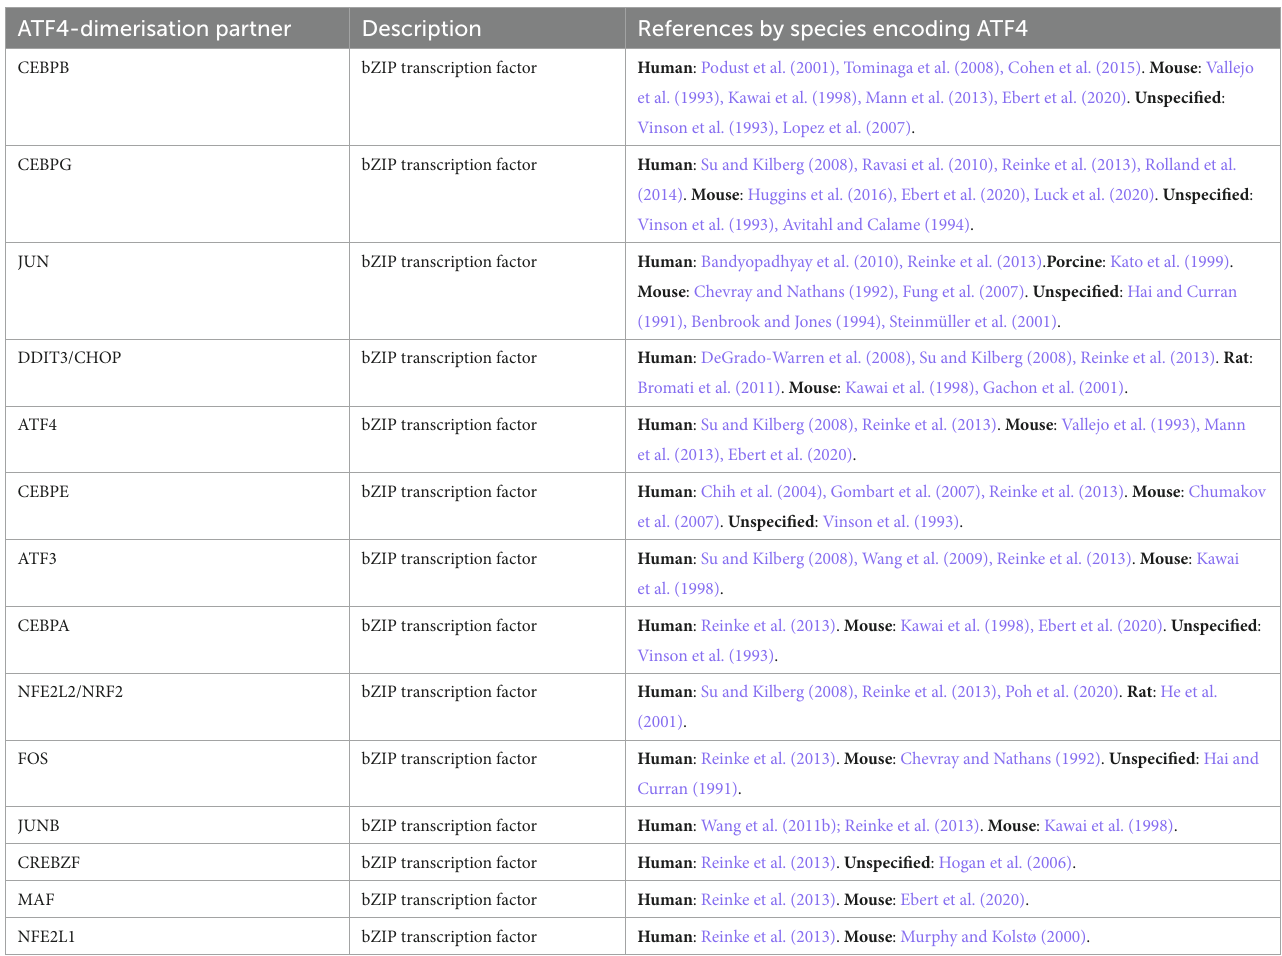
TABLE 1 Direct ATF4 dimerisation